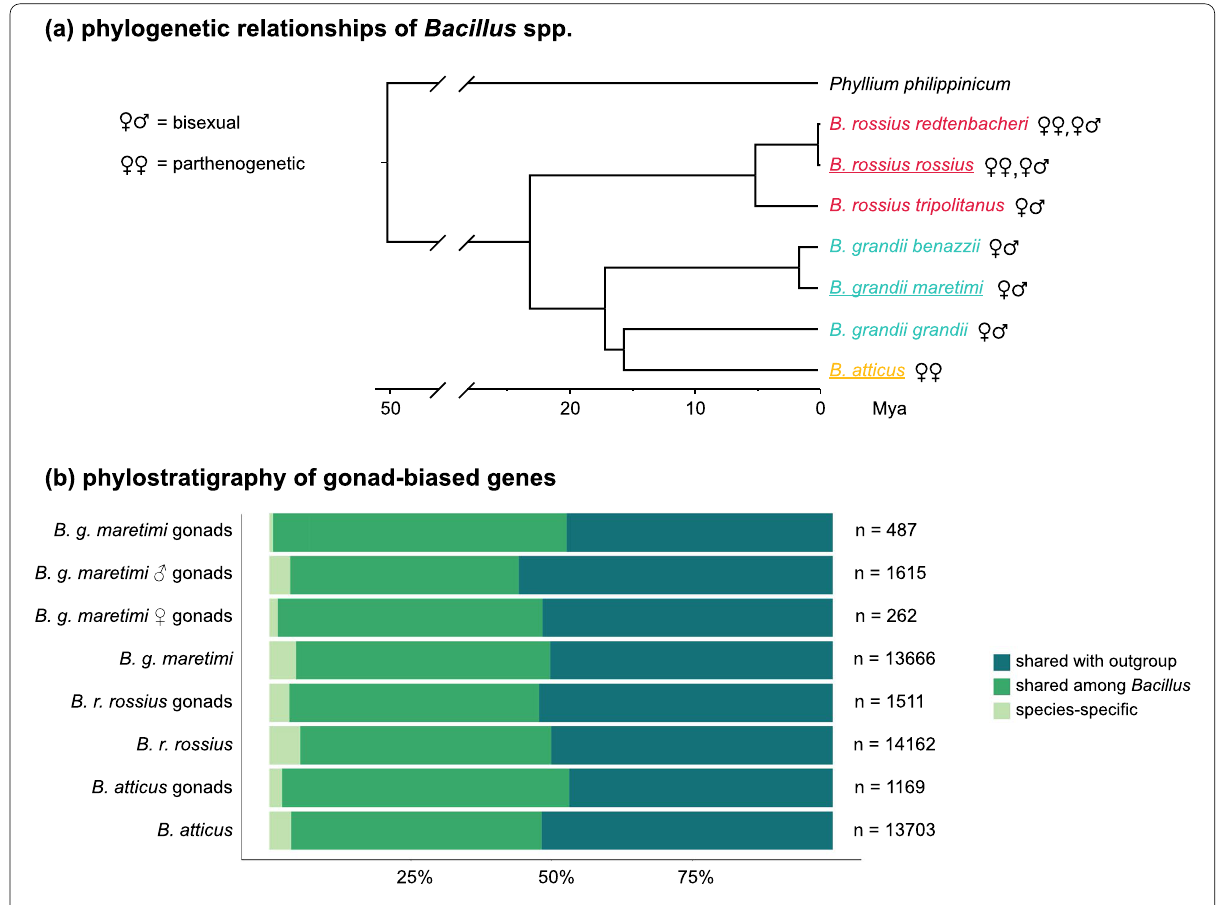
Fig. 2 Phylogenetic relationships of Bacillus taxa and phylostratigraphy of gonads-biased genes. a Schematic drawing of the species tree obtained from Mantovani et al. (2001), with indication of the reproductive strategy for each taxon. Underlined species are those considered in the present study. b Phylostratigraphy of gonads upregulated genes; numbers on the right represent the number of transcripts present in each subset /